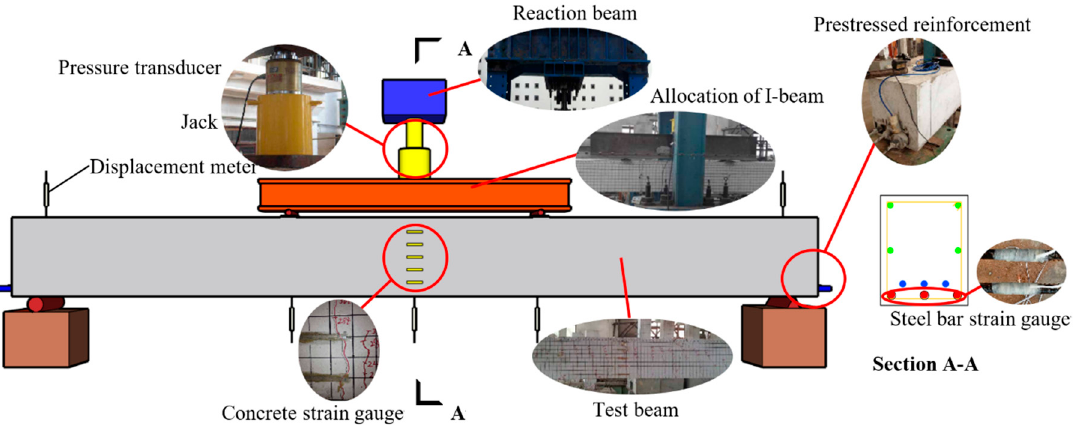
Figure 2. Experimental model and apparatus of the test